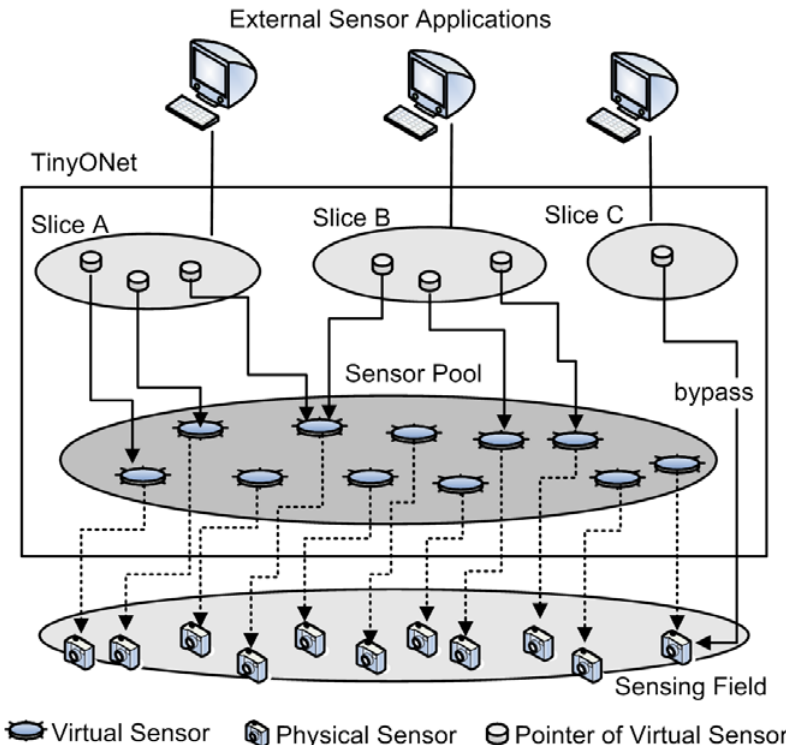
Figure 1. Conceptual design of